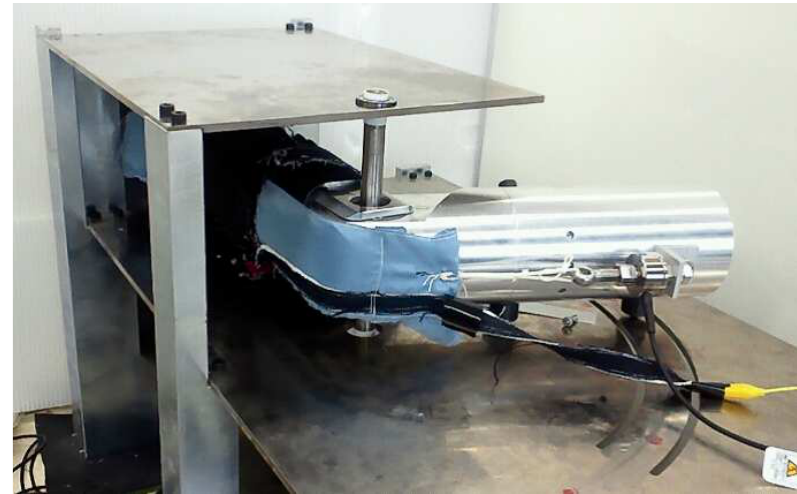
Figure 9. Testbed for a winding EA gel sliding orthogonally.